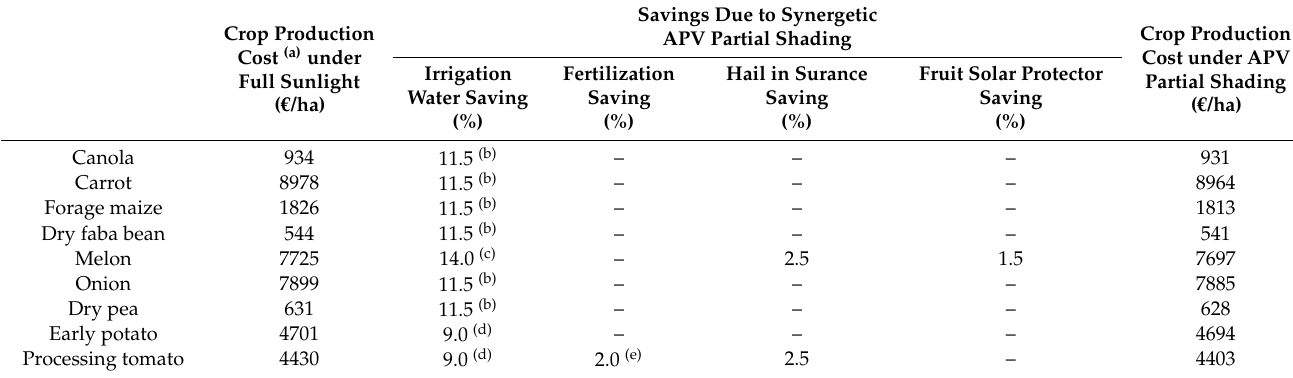
Table 4. Crop production cost under full sunlight and under APV partial shading (in both cases assuming irrigation with surface